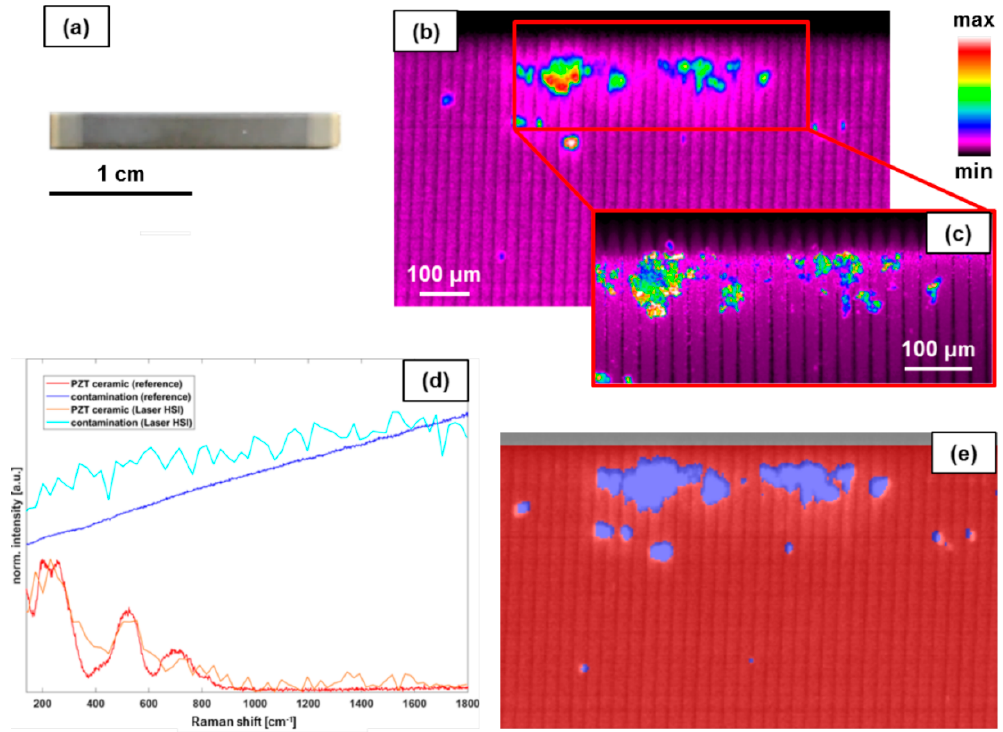
Figure 5. Results of the fourth experiment. ( a ) Picture of the measured PZT piezoelectric actuator. ( b ) False color image of the measured intensity at ~230 cm − 1 measured with the Laser-HSI. ( c ) False color image of the measured intensity at ~230 cm − 1 measured with the Raman microscope. ( d ) Normalized example spectra of the PZT ceramic and the contamination and reference spectra acquired with the Raman microscope. ( e ) Classification result of the Laser-HSI measurement (blue = contamination; red = PZT ceramic).